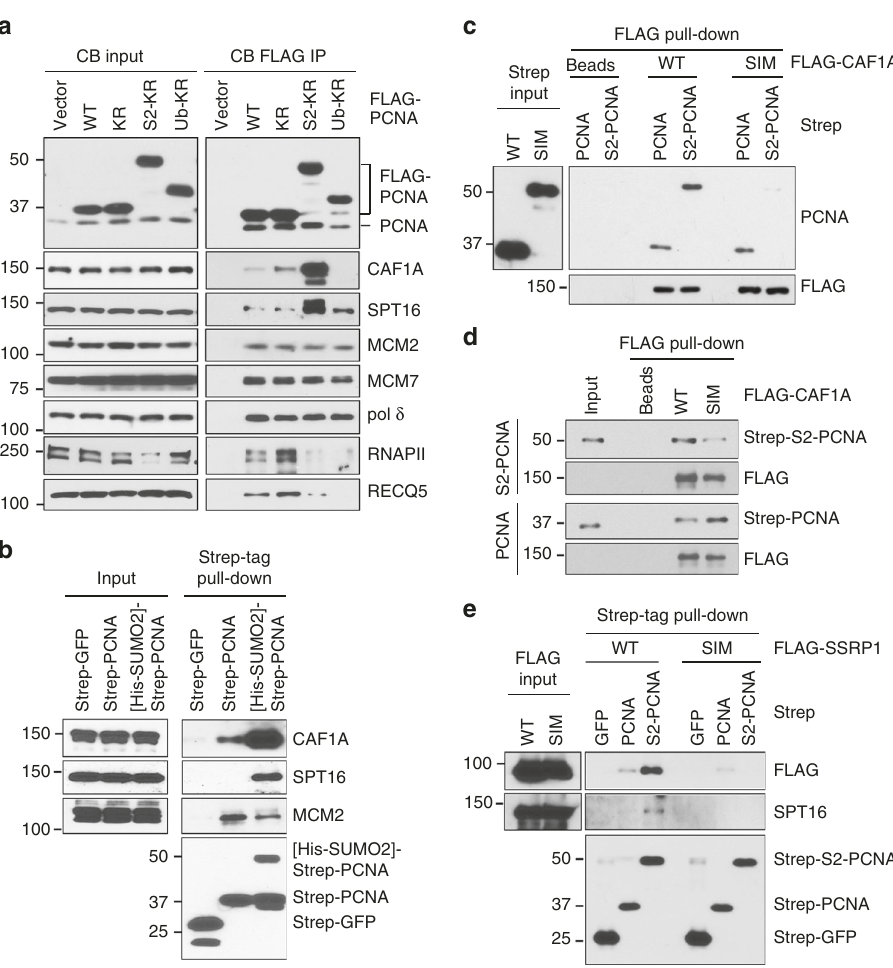
Fig. 4 SUMO2-PCNA enriches CAF1 and FACT within the replication complex. a Western blot analysis of the indicated proteins in the CB fractions (left) and the FLAG-PCNA complexes puri fi ed from CB fractions (right) prepared from cells expressing the indicated FLAG-tagged proteins. Ub-KR indicates the FLAG-ubiquitin-PCNA (KR) fusion protein. b Western blot analysis of the indicated proteins in the CB input (left panels) used for the in vitro pull-down experiments of puri fi ed recombinant strep-tagged PCNA, SUMO2-conjugated PCNA, and GFP anchored to Strep-Tactin resins (right panels). SUMO2- modi fi ed PCNA was generated by the in vitro SUMOylation reaction using strep-PCNA and His-SUMO2 shown in Supplementary Fig. 6a, b. c Western blot analysis of the input levels of recombinant strep-PCNA and strep-SUMO2-PCNA fusion (S2-PCNA) puri fi ed from E. coli (left panel) and of strep-PCNA and strep-S2-PCNA pulled down by WT or SIM mutant FLAG-CAF1A proteins puri fi ed and anchored on FLAG M2 agarose beads from HEK293T cells expressing the corresponding constructs (right panels). d Western blot analysis of strep-S2-PCNA (upper 2 panels) and strep-PCNA (lower 2 panels) pulled down by FLAG-CAF1A puri fi ed from E. coli and anchored on FLAG M2 agarose beads. e Western blot analysis of the indicated proteins in the CB input prepared from HEK293T cells expressing FLAG-SSRP1 WT or SIM mutant (left panels) and of FLAG-SSRP1 and SPT16 pulled down from the